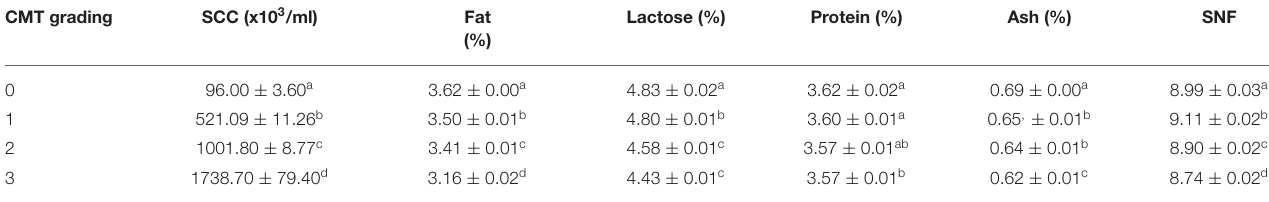
TABLE 3 | Cow milk somatic cell count ( × 10 3 /mL) and other milk constituents in relation to CMT grading on the basis of severity of mastitis (mean ± SE). CMT grading